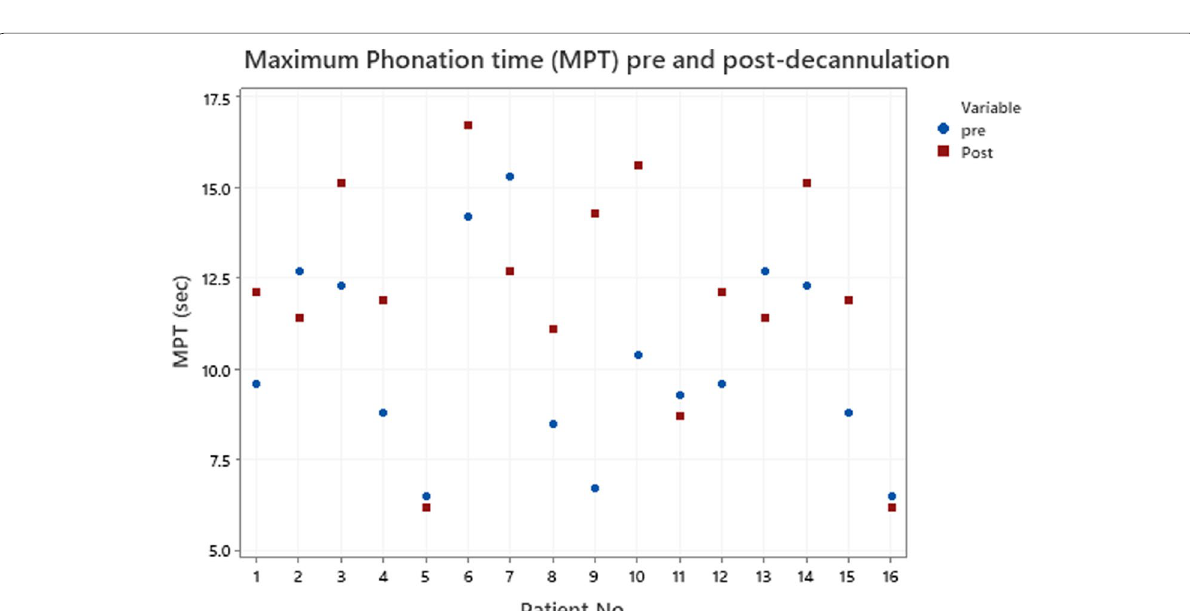
Fig. 4 Plot distribution of maximum phonation time in all studied subjects before and after